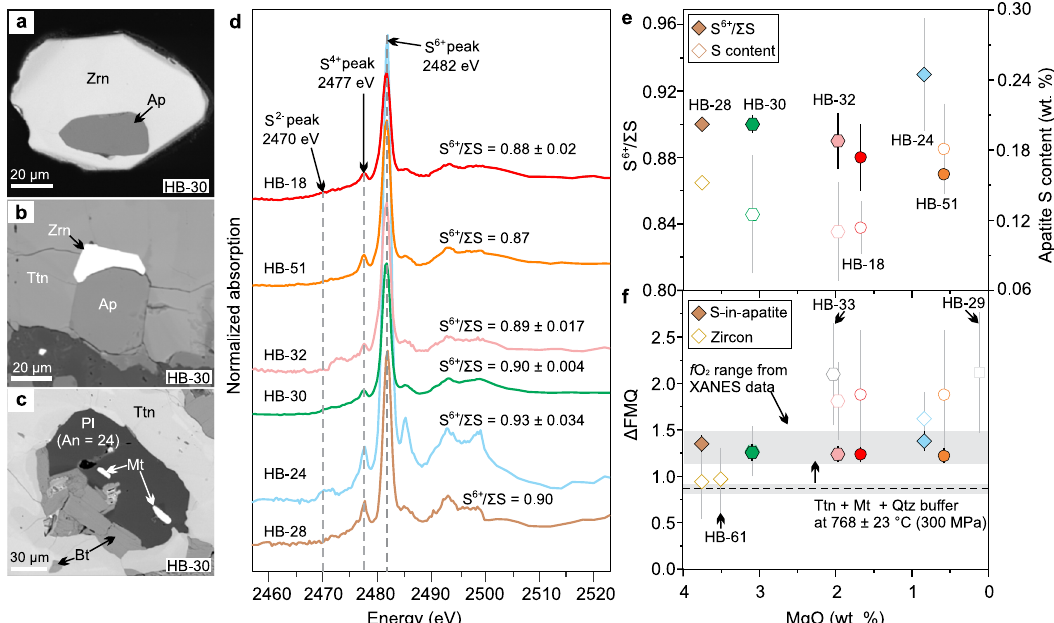
Fig. 4 Backscattered electron images of inclusions in titanite and zircon, apatite μ -XANES spectra and sulfur contents, and results of magmatic f O 2 estimation. a Representative apatite inclusion in zircon from sample HB-30; BSE. b Zircon overgrowth on apatite with both hosted in magmatic titanite from sample HB-30; BSE. c Biotite, plagioclase (An number = 24, calculated from energy-dispersive X-ray analysis), and magnetite in titanite from diorite sample HB-30; BSE. d Normalized μ -XANES spectra at the S K -edge of apatite in zircons for representative igneous rocks from Haib. Spectra for only one apatite inclusion ( n = 1) were obtained for samples HB-28 and HB-51, respectively, while the others represent averaged spectra of a number of apatite inclusions (HB-18, n = 4; HB-24, n = 2; HB-30, n = 3; HB-32, n = 3). Peak positions for S 2 − , S 4 + , and S 6 + are at 2470 eV, 2477 eV, and 2482 eV, respectively, and are shown as dotted gray lines. The average S 6 + / Σ S ratios (1 σ ) are calculated from the merged spectra following ref. 22 . e Plot of apatite S 6 + / Σ S ratios and S contents versus MgO for the representative samples. f Δ FMQ values versus MgO for the representative samples. Error bars in ( e ) and ( f ) represent 1 σ uncertainties. An anorthite, Ap apatite, Bt biotite, Mt magnetite, Pl plagioclase, Ttn titanite, Zrn zircon. Symbols and colors are the same as in Fig.